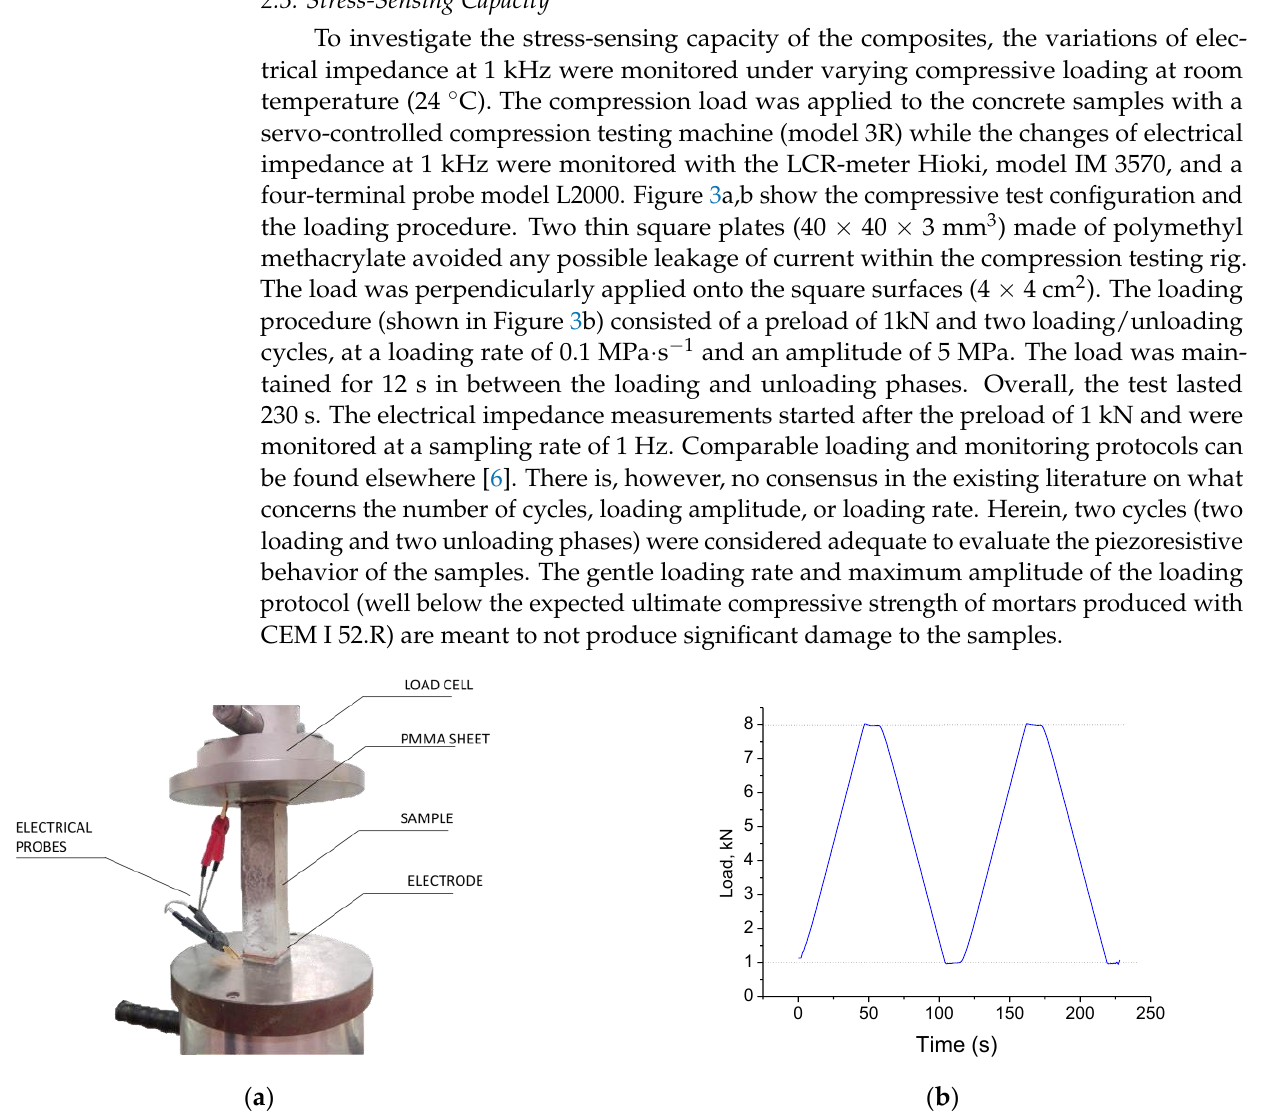
Figure 2. ( a ) Conceptual Nyquist representation of typical EIS data of cement-based composites in- corporating electrically conductive short fibers and ( b ) equivalent circuit.